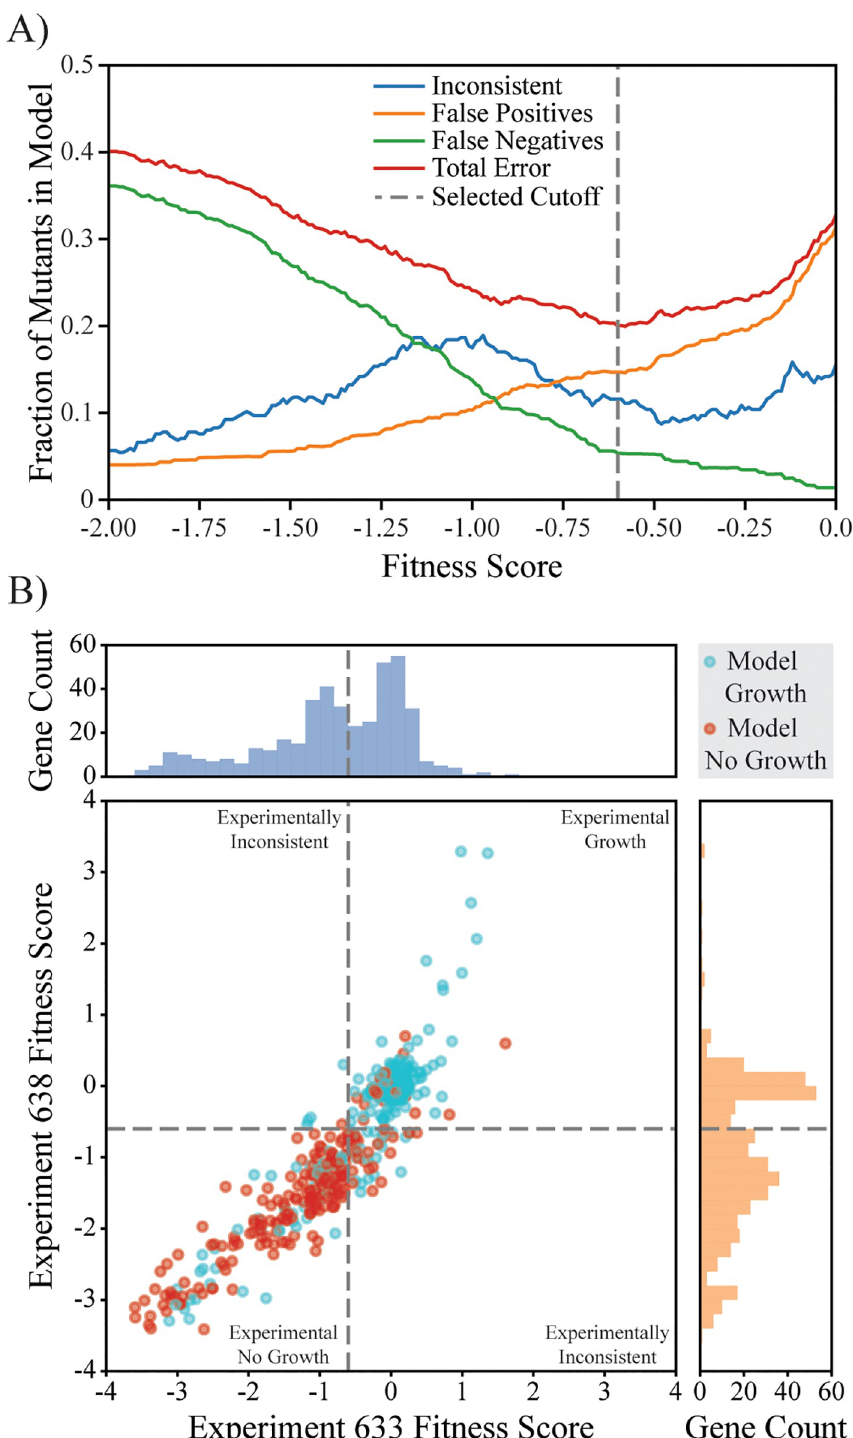
Fig 2. Comparison of model predictions to pooled fitness data. (A) Analysis of the effect of fitness score cutoff for growth phenotype classification of the pooled growth experiments. The fraction of genes with inconsistent growth phenotypes (i.e., above the cutoff in one experiment and below in the other) is shown in blue, the fraction of false positives (model predicts growth, but categorized as no growth experimentally, i.e., GNG mutants) in orange, the fraction of false negatives (model predicts no growth, but categorized as growing experimentally, NGG mutants) in